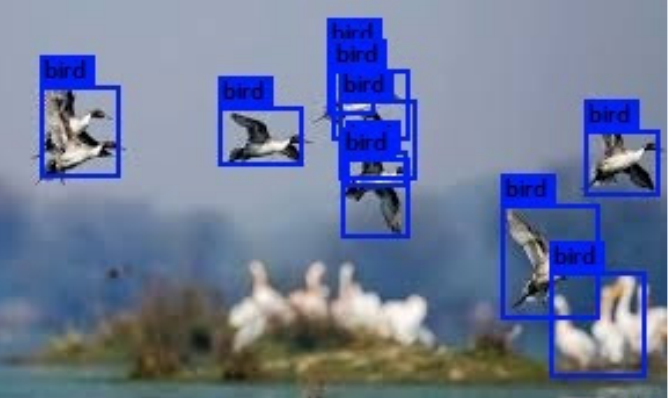
Figure 19. Object detection and recognition from an image (Example 3).